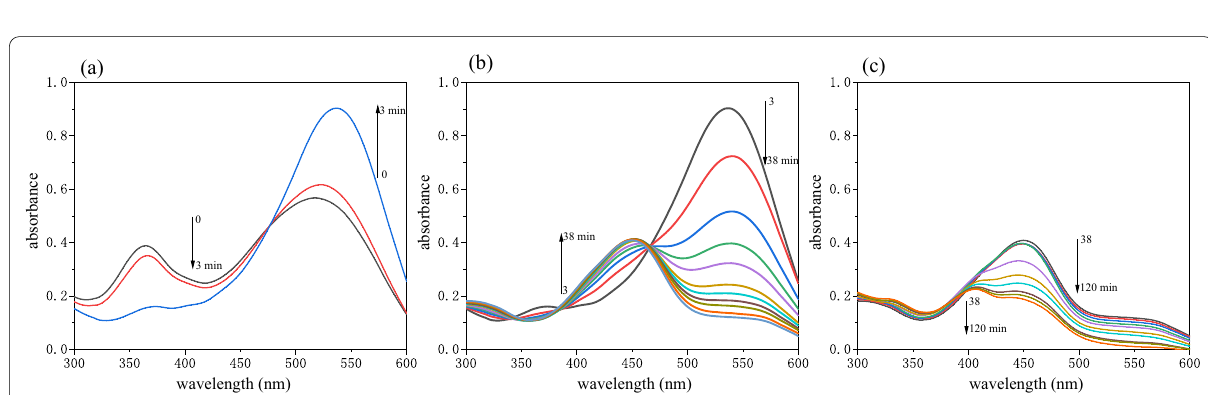
Fig. 3 Time-dependent absorption spectra of probe BCD (60 µM) at different time scales upon addition of N 2 H 4 (100 µM) in DMF-Hepes buffer (7/3, v/v, pH =